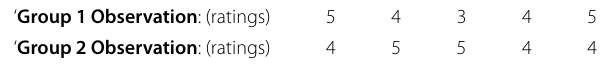
Table 5 ‘Ratings (LIKERT) of observations polled from organizations & public domains on perceptions of risks & mitigation, climate change, brand culture and their relationship